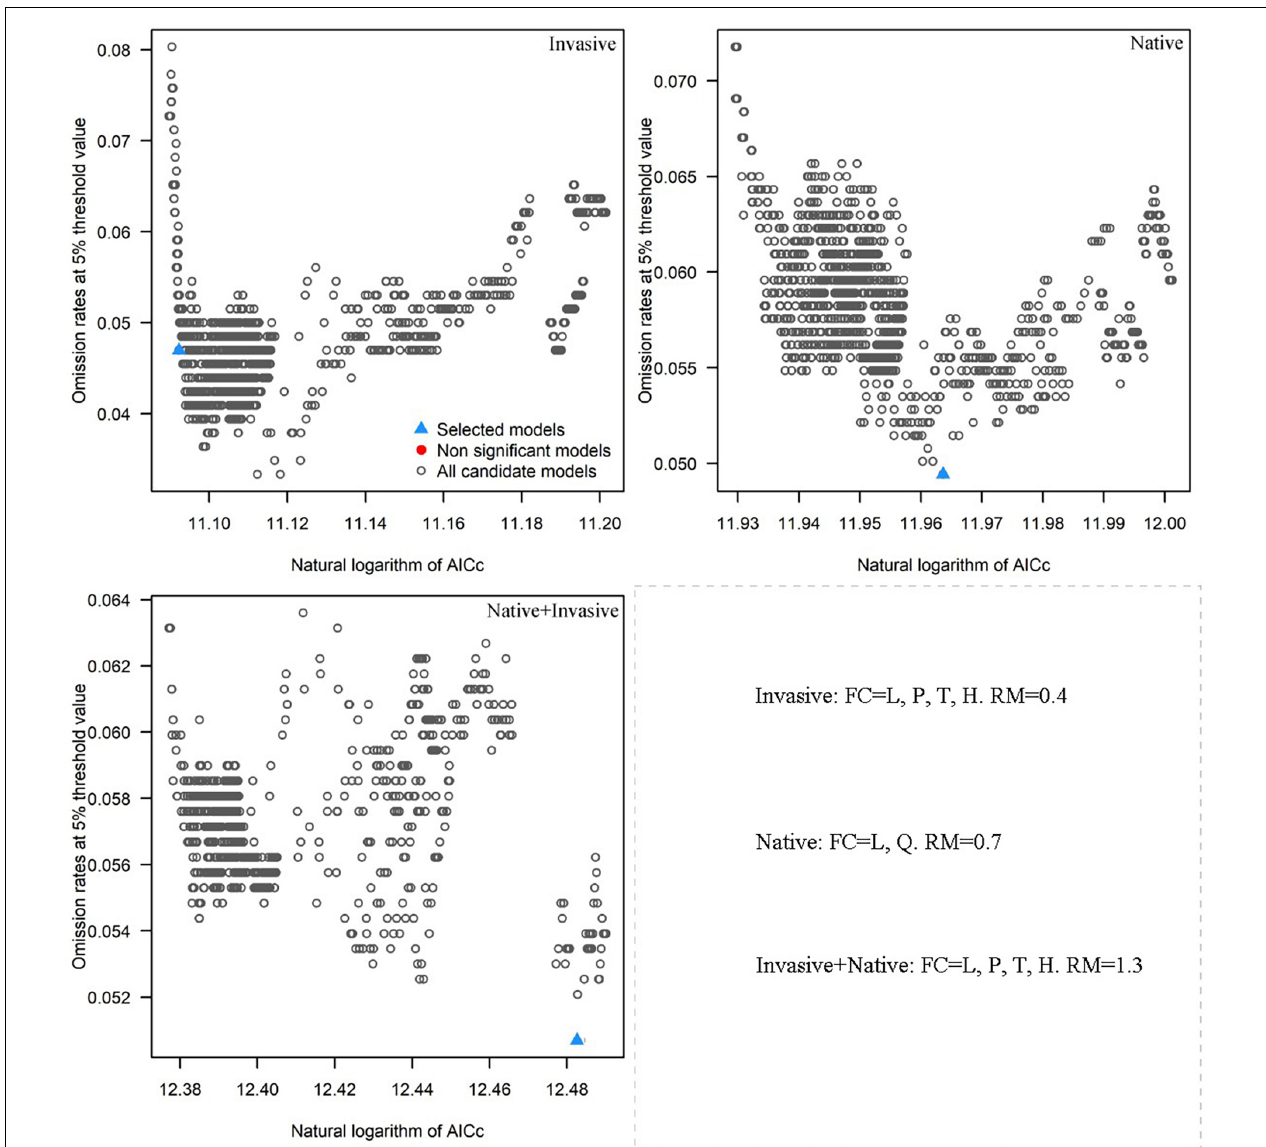
FIGURE 2 | Omission rates and AICc values for all, non-significant, and selected “best” candidate models based on the invasive, native, and native + invasive records of Rapistrum rugosum